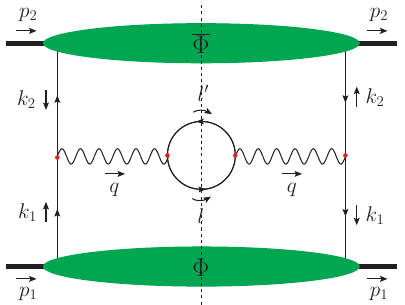
Figure 1: The DY process at leading order: a quark and antiquark are extracted from the colliding hadrons, producing a virtual photon that subsequently decays into a lepton pair. The green ‘blobs’ represent the quark and antiquark correlators, and the dotted line in the middle represents the final-state